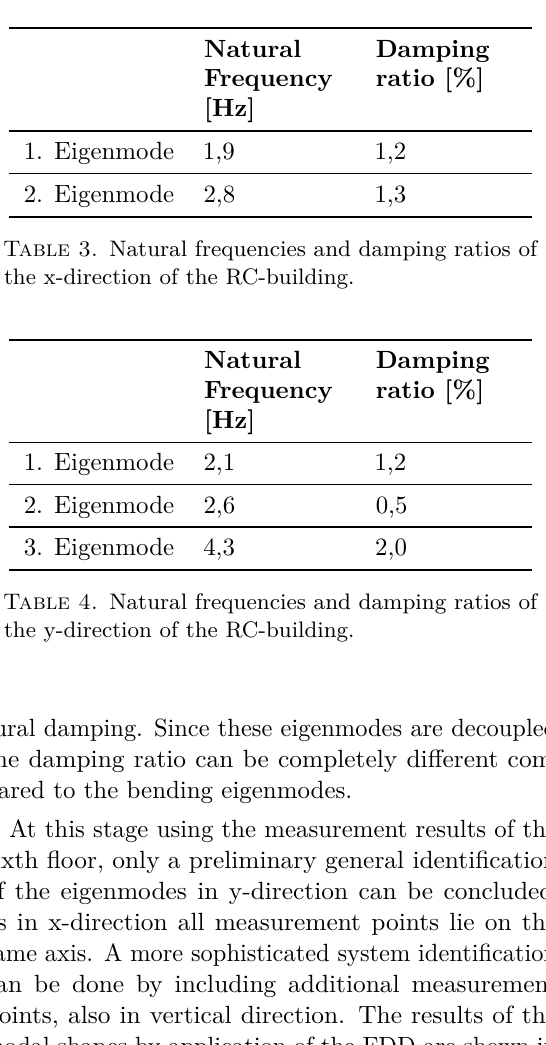
Table 2. Comparison of the damping ratios of the 4-dof system.